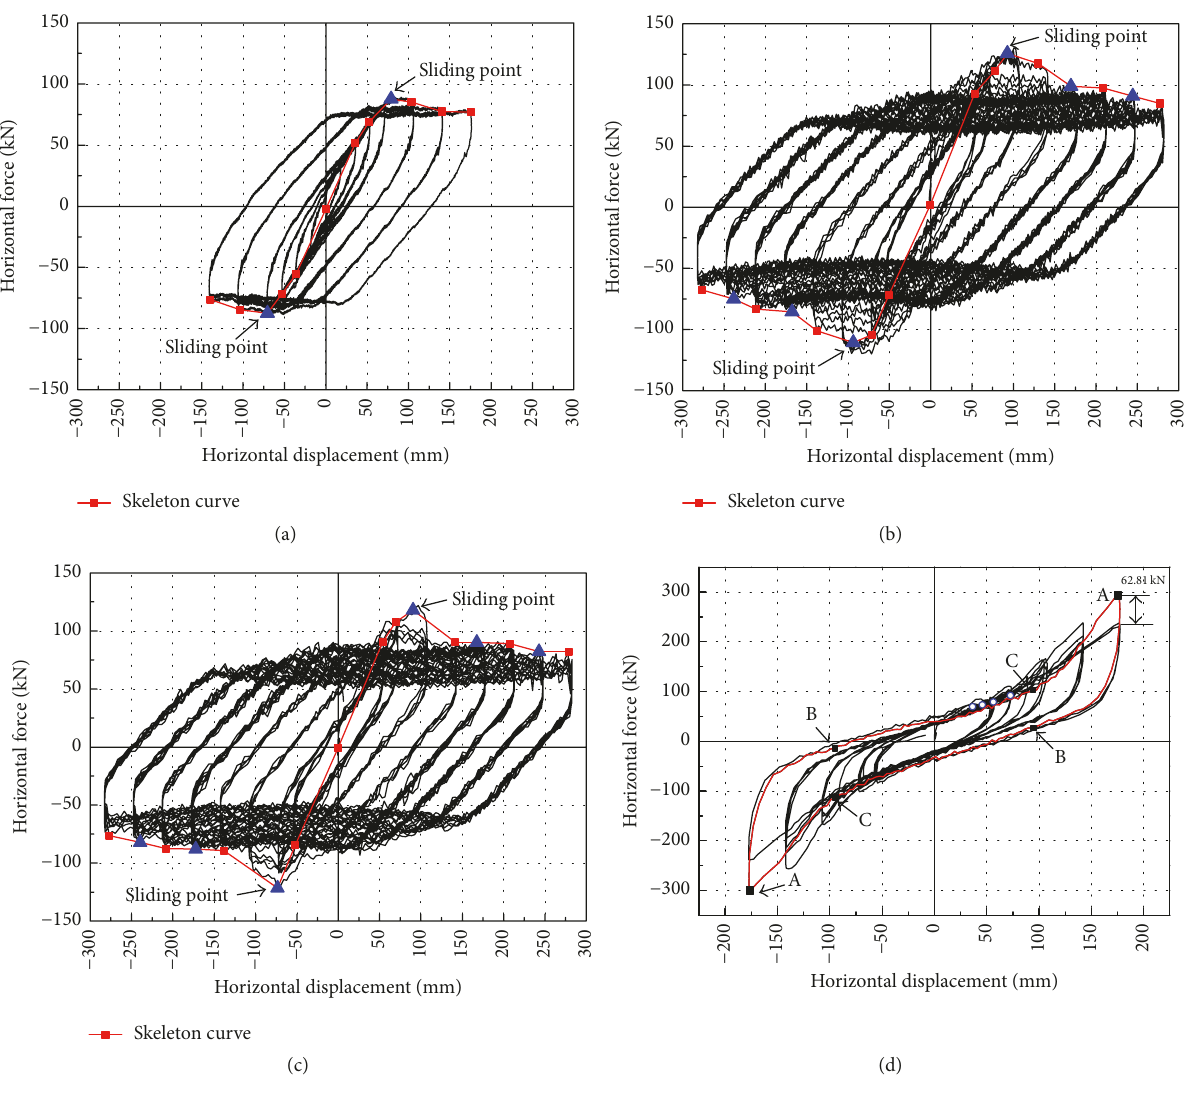
Figure 5: Force versus displacement results for the cyclic tests: (a) Y2-8/3-UB; (b) Y2-8/30-UB; (c) Y2-8/45-UB; (d) Y3-8/45-BB.